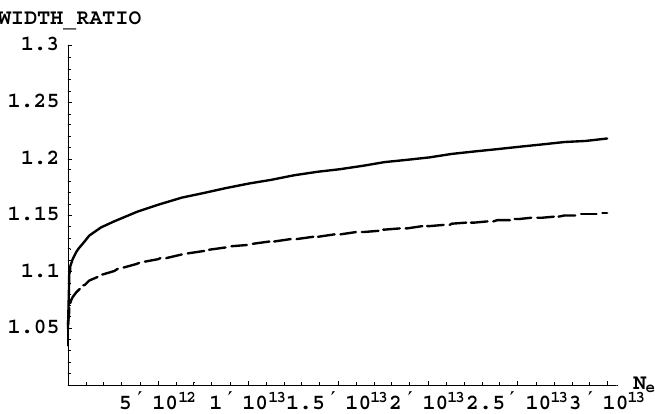
Figure 3. The ratio of the ion dynamical Stark width with the allowance for the center-of-mass motion to the ion dynamical Stark width from the conventional theory [29] versus the electron density N e (cm − 3 ) for the H α line emitted from a hydrogen plasma at T = 0.17 eV for C = 2 (solid line) and for C = 3/2 (dashed line) [17]. Plasma parameters correspond to radiofrequency discharges.